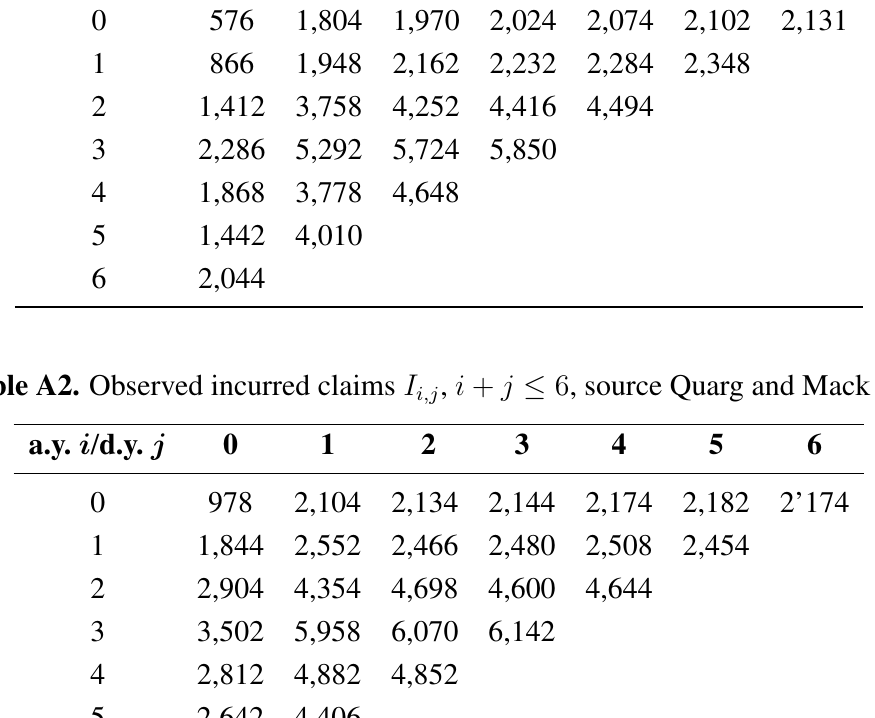
Table A1. Observed cumulative payments P